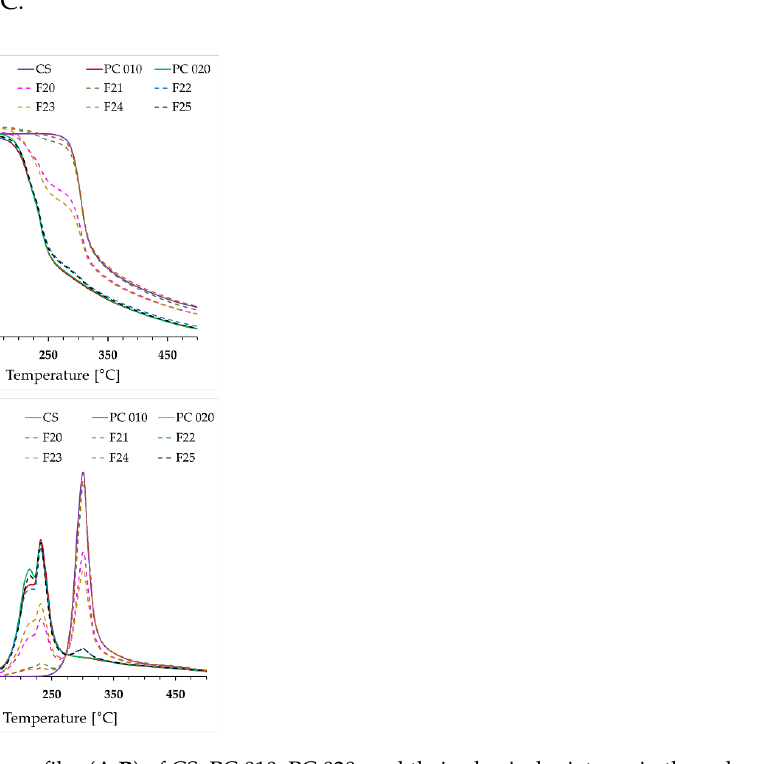
Figure 6. TGA profiles ( A , B ) of CS, PC 010, PC 020, and their physical mixtures in the polymer ratios corresponding to the films composition (F20—CS:PC 010 1:1, F21—CS:PC 010 10:1, F22—CS:PC 010 1:10, F23—CS:PC 020 1:1, F24—CS:PC 020 10:1, F25—CS:PC 020 1:10).